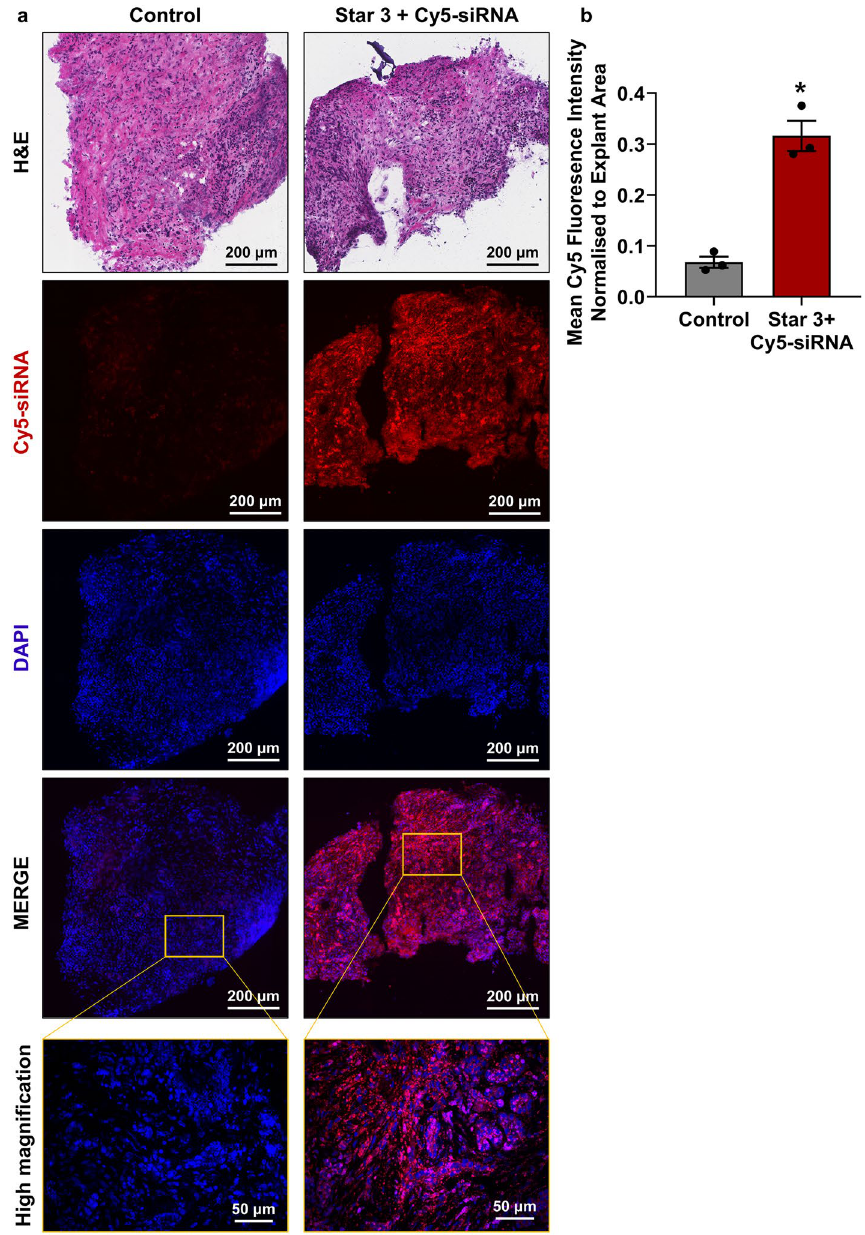
Figure 8. Biodistribution of Star 3 nanoparticles in human patient derived pancreatic ductal adenocarcinoma explants. (a) Patient-derived explants from patient 13 were treated for 24 h with or without Star 3 polymeric nanoparticles coupled to Cy5-siRNA. Representative images show uptake of Cy5-siRNA throughout the entire explants. (b) Quantification of Cy5 mean fluorescence demonstrated significant uptake of Star 3 + Cy5-siRNA in treated explants compared to untreated controls. A paired t-test was performed to compare mean fluorescence normalised to explant area from a single patient, with 3 explants per treatment from distinct regions of the patient’s tumour (represented by each dot in the bar graph). Bars represent mean ± S.E.M., *p =